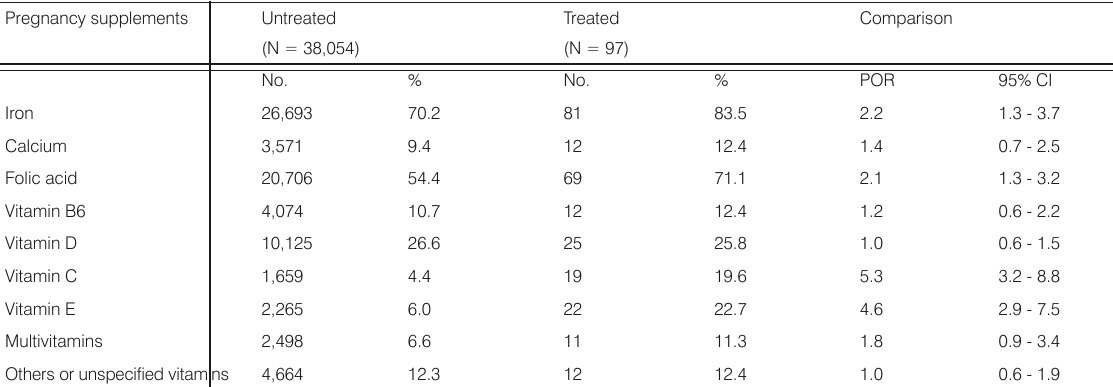
Table 3. Use of pregnancy supplements by mothers with or without HCG